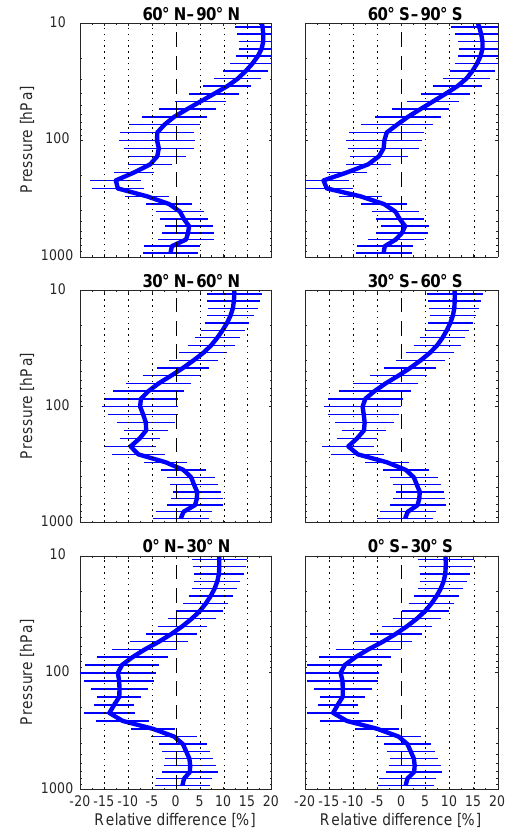
Figure 18. Mean relative differences (in percent) between FORLI v20140922 and FORLI v20151001 averaged over six 30 ◦ lat- itude bands for daytime measurements. The standard deviation profiles are overlaid. The relative difference is calculated as 100 × (v20140922 − v20151001) /